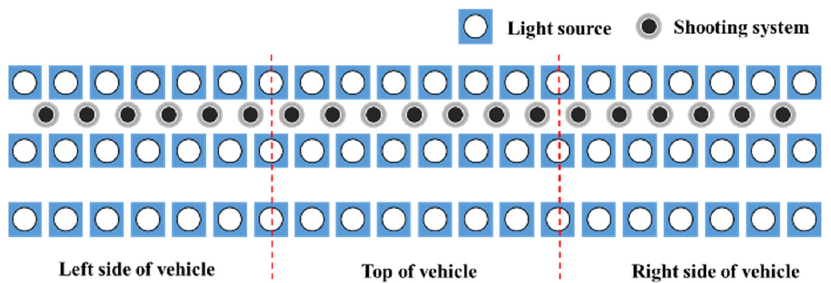
Figure 3. Layout of the machine vision system for tunnel inspection vehicle.